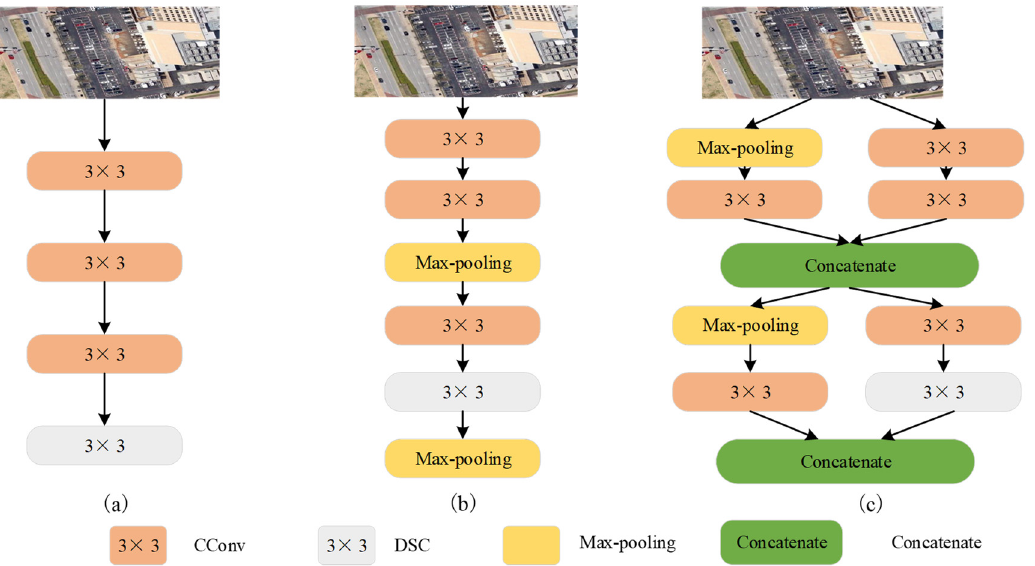
Figure 2. Three downsampling structure diagrams. ( a ) Convolutional Downsampling ( b ) Maximum Pooled Downsampling ( c ) Our proposed downsampling method (each convolution layer is followed by BN layer and RELU).